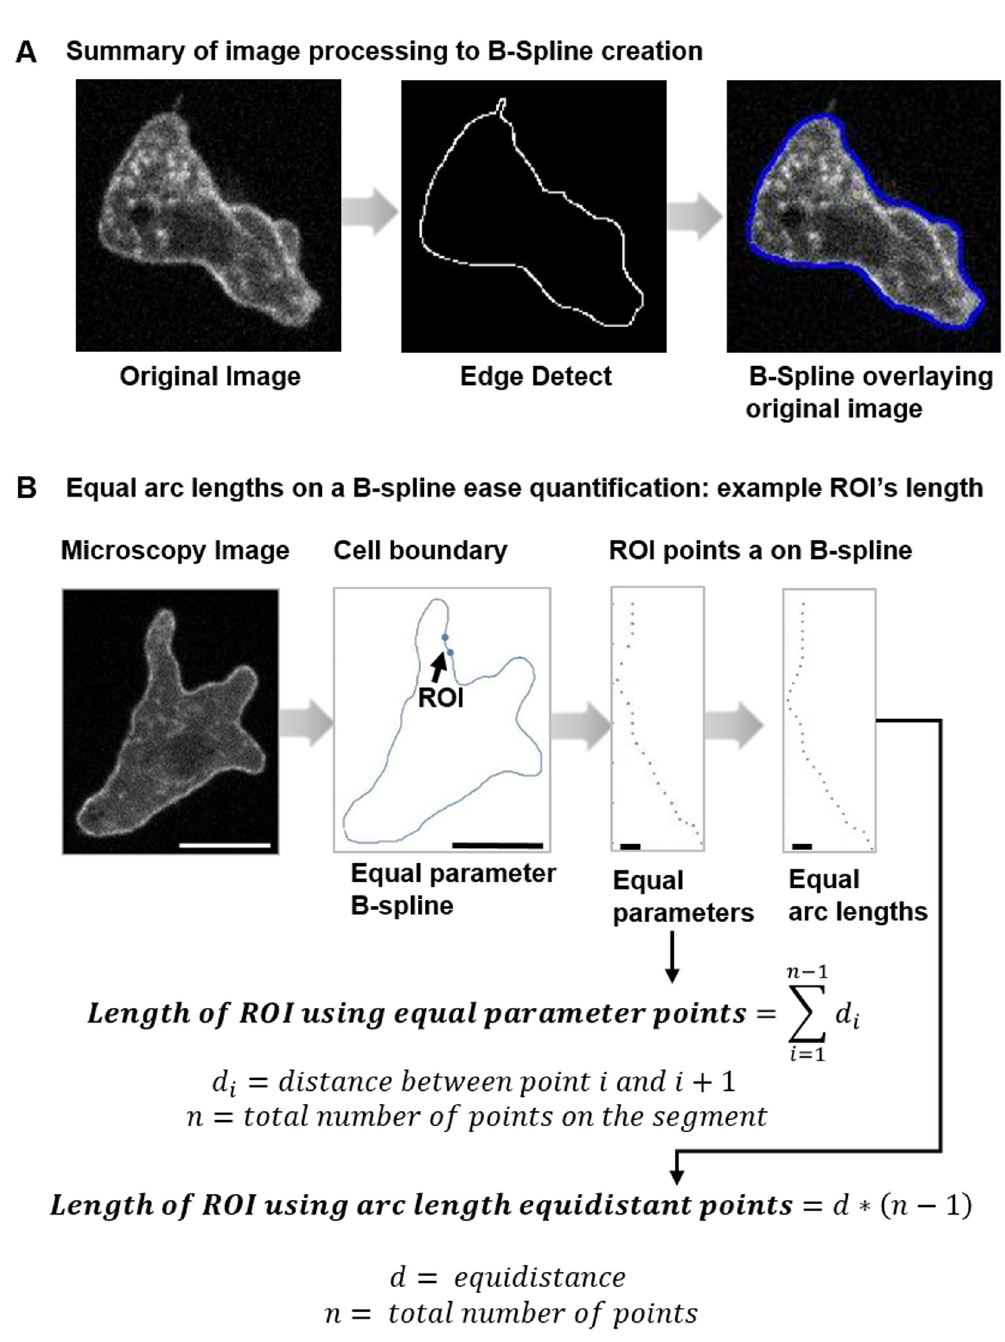
Fig 6. Creation of B-splines and equal arc length points. (A) Three views of a cell: the microscopy image, the edge detect image, the B-spline plot overlaying the microscopy image. (B) The entire cell followed by two views of the boundary segment. The ROI view shows points on the B-spline at equal parameter increments, t = 0.5, and the same segment with points at equal arc length intervals, δ = 0.5 pixel units and � = 0.001 pixel units. Large scale bars identify 10 micron lengths; small scale bars identify 1